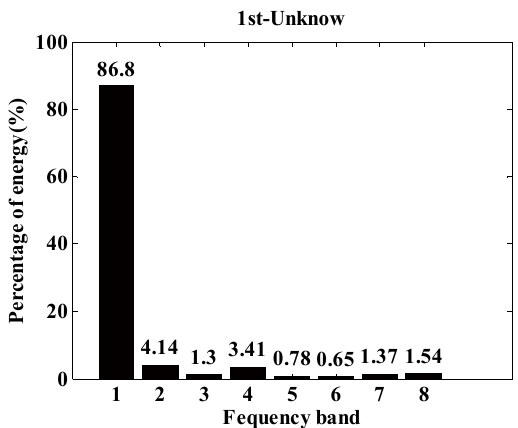
12 of 15 Figure 8. The second transformer's vibration signal cumulative probability distribution curve FSL comparison diagram. In Figure 7, the cumulative probability distribution curve FSL slope of the vibration signal of the first unknown-fault transformer in the short-circuit test is calculated to be 10.1912, which is in the range of the linear slope of the transformer during the short-circuit fault of the neutral winding. Therefore, the transformer has a moderate winding short-circuit fault. And in Figure 8, when the